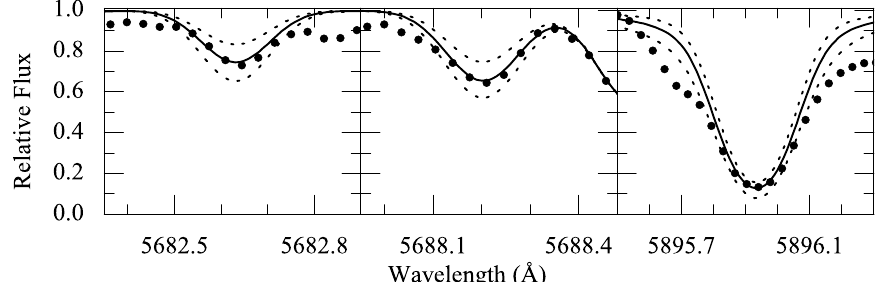
Fig. 12. Na I lines in the spectrum of HD 209621. The synthetic spectra are given for the sodium abundance log ϵ (Na) = 4.90 ± 0.3. from equivalent widths was found to be log ϵ (Sc) = 1 . 88. Hyperfine structure (HFS) data for the selected lines was obtained from the Kurucz website 4 (hereafter referred to as KLL). Spectral synthesis of the two profiles at 5657.9 and 5684.2